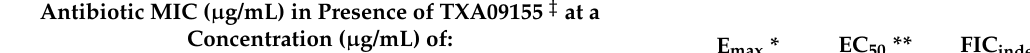
Table 2. Synergistic in vitro activity of TXA09155 combined with various antibiotics against wild-type P. aeruginosa ATCC